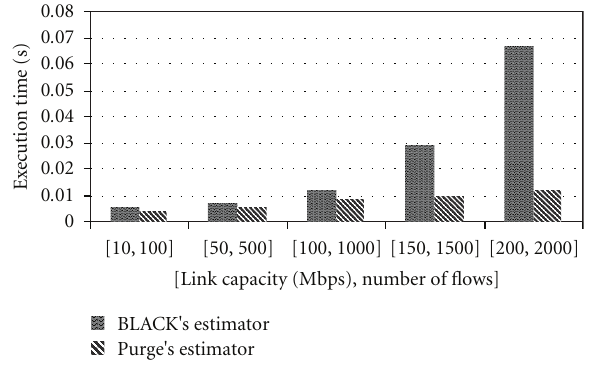
Figure 5: Execution time of the N act